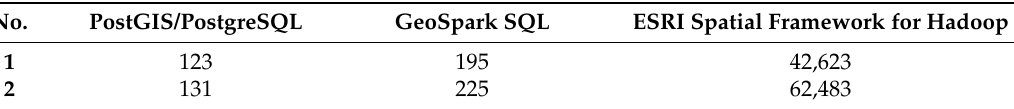
Table 15. Performance of directional queries (in milliseconds).